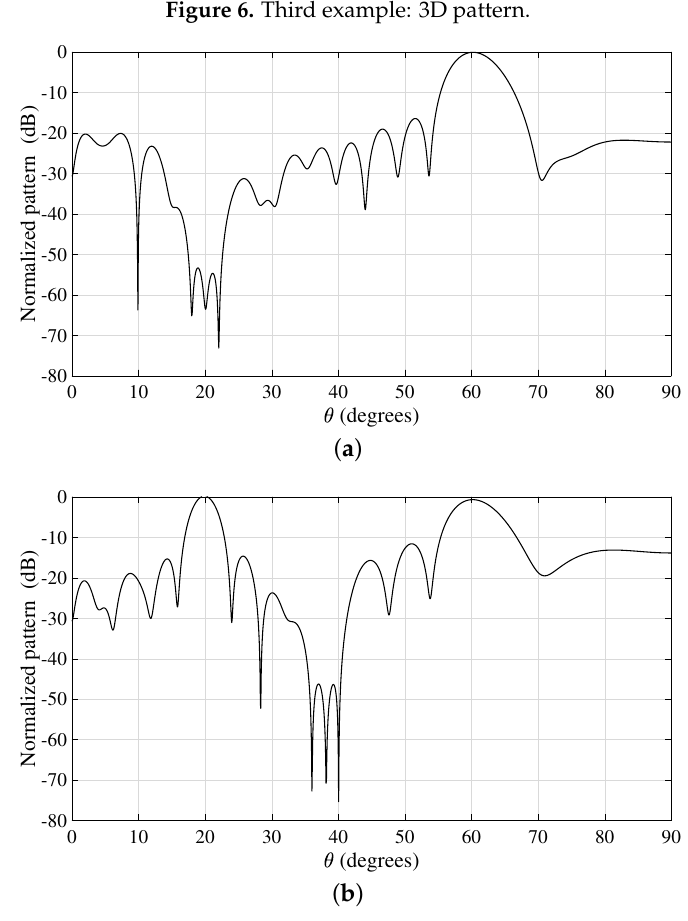
Figure 7. Third example: 2D pattern cuts at ( a ) φ = − 25 ◦ and ( b ) φ = 45 ◦